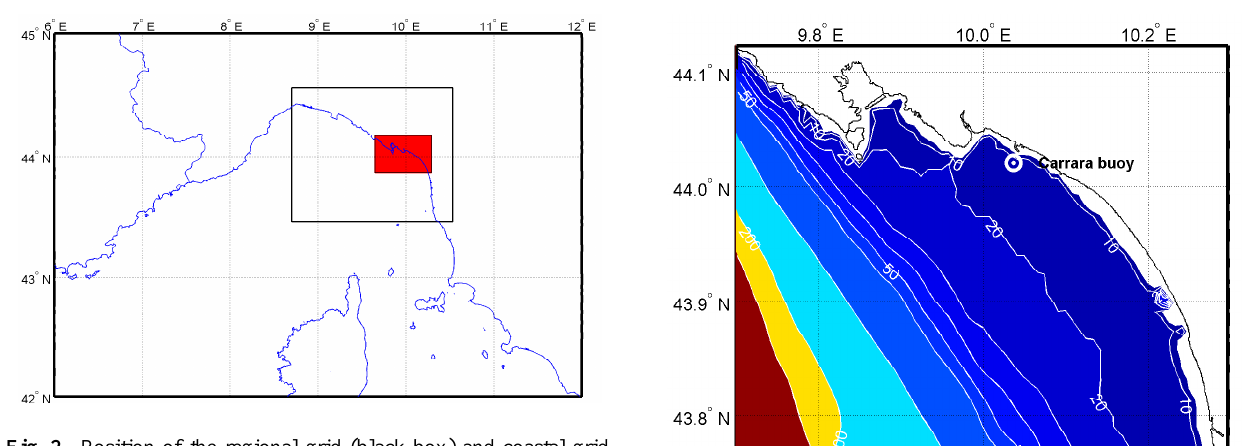
Fig. 2. Position of the regional grid (black box) and coastal grid (red box) in the Ligurian Sea.